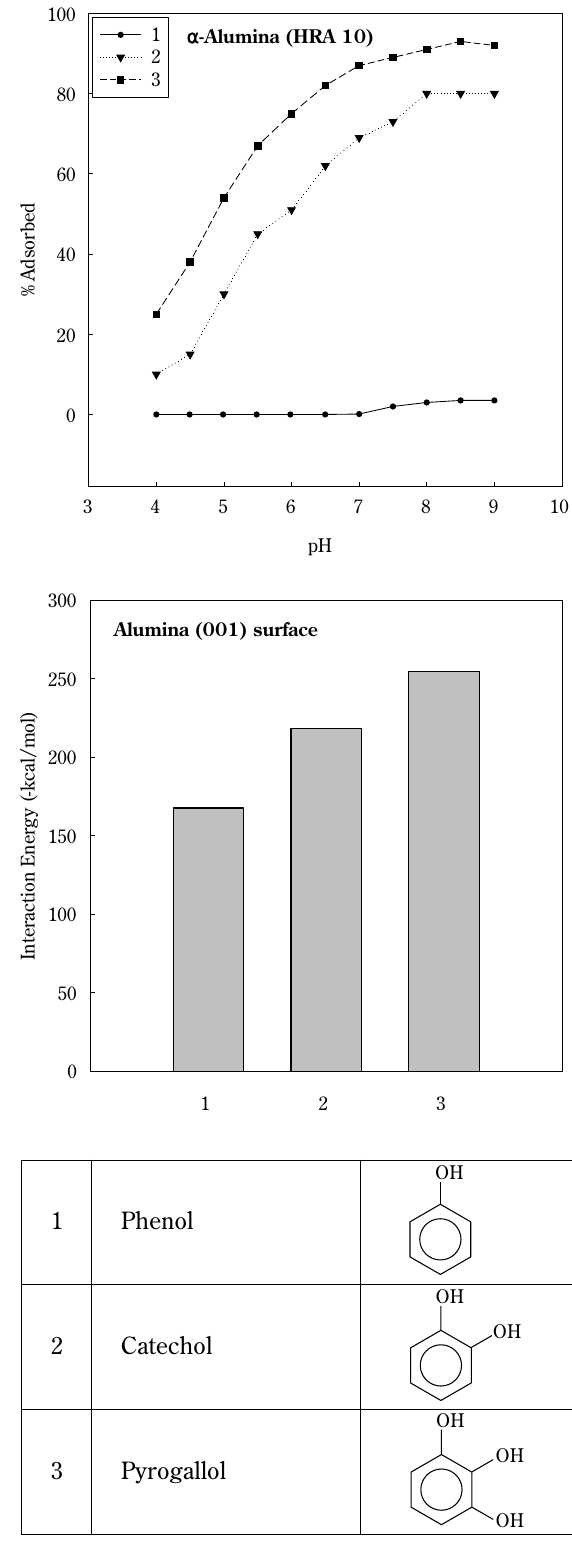
Fig. 3 (a) Adsorption curves for phenol, catechol and pyrogallol on α -alumina (data taken from Ref. [45]), (b) Theoretically computed interaction energies obtained using MD simula- tions in presence of